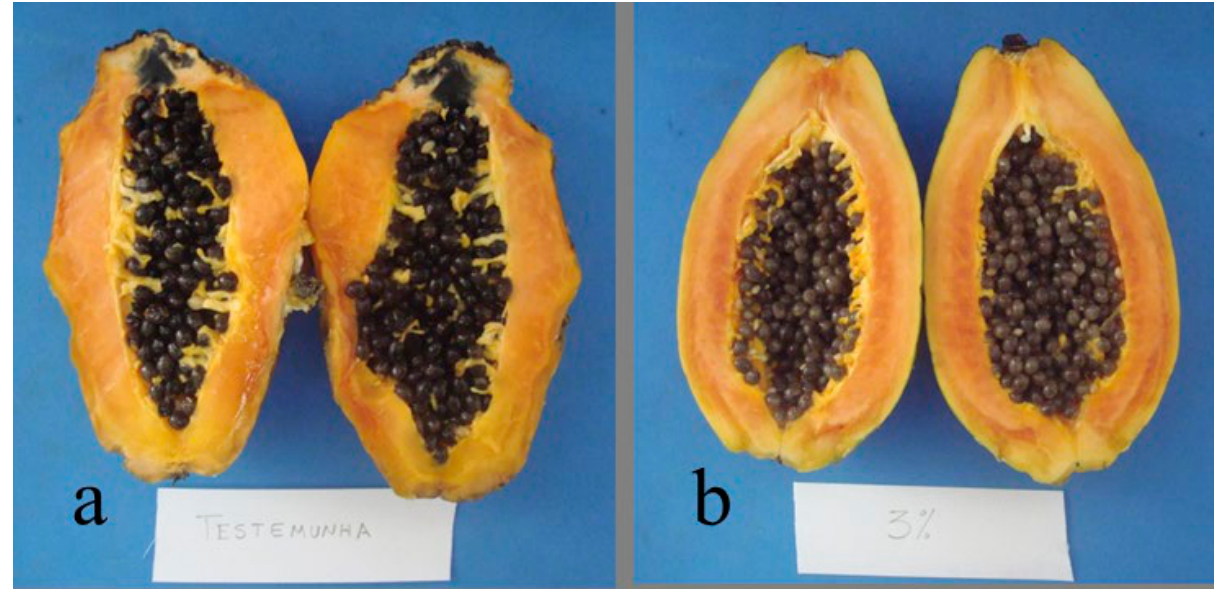
Figure 3. Sections of longitudinally cut of papaya fruits 12 d after coating: a) control fruit (only inoculated with Colletotri- chum gloeosporiopides ) and b) fruit coated with 3% starch-based